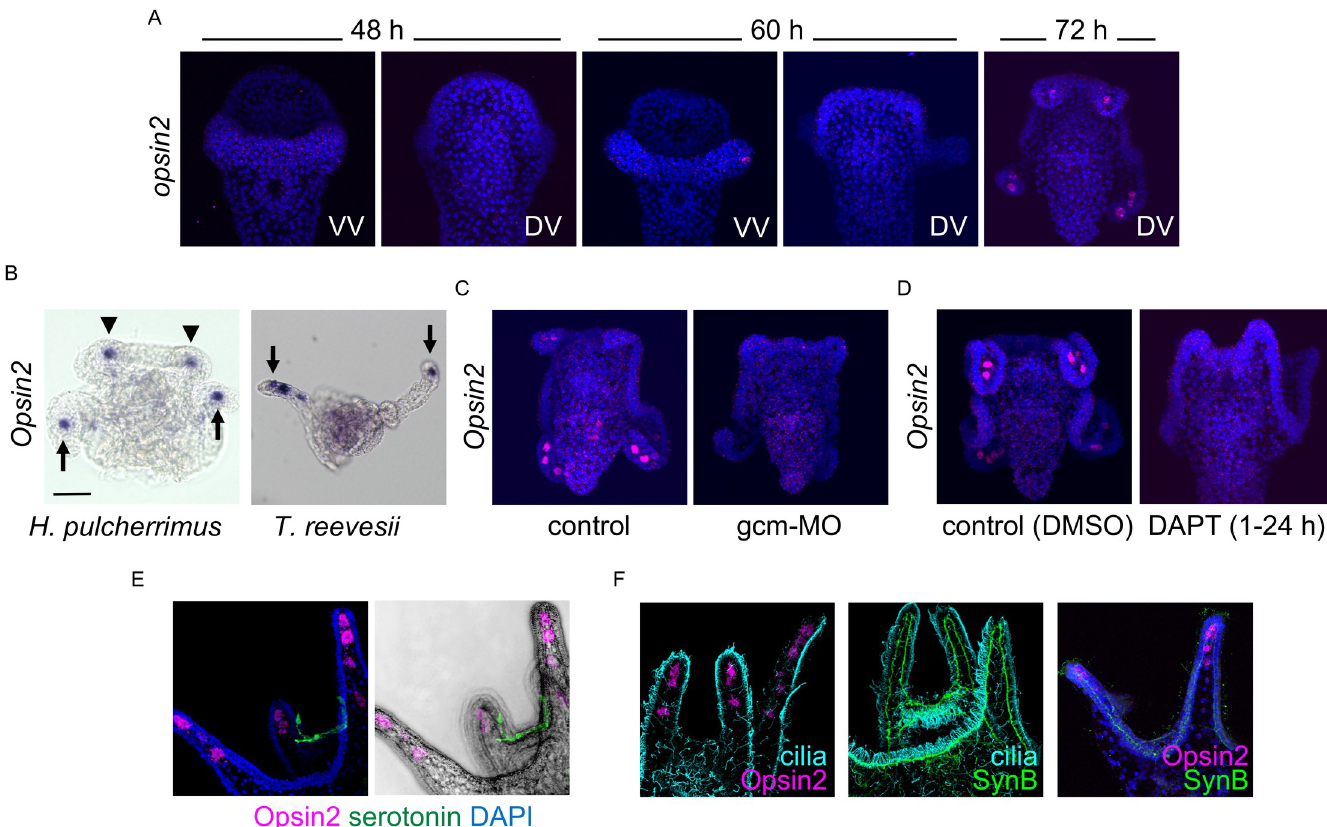
Fig 2. Opsin2 expression during embryogenesis. (A) Fluorescent in situ hybridization of Opsin2 mRNA. Although 48-hour-old larvae showed no mRNA signal, 72-hour-old larvae clearly had Opsin2 expression at the tips of their arms. VV, ventral view; DV, dorsal view. (B) Chromogenic in situ hybridization of Opsin2 mRNA in pluteus larvae of H . pulcherrimus and T . reevesii . Bar = 20 μ m. The arrows and arrowheads show Opsin2 -expressing cells in the postoral arms and preoral arms, respectively. The Opsin2 -expressing cells in the preoral arms of T . reevesii are out of focus in this image. (C, D) The expression of Opsin2 was abrogated in larvae in which the secondary mesenchymal cell specifier Gcm (C) or Delta-Notch signal (D) was attenuated. (E) Opsin2 protein was expressed in the same cells expressing Opsin2 mRNA. Green shows serotonergic neurons. Blue in the left image shows the nuclei. The fluorescent image is merged with the brightfield image on the right. (F) Opsin2-expressing cells were close to the ciliary band and neurons. Major neuronal axons, which express the panneural marker synaptotagmin B (SynB), were located beneath the ciliary